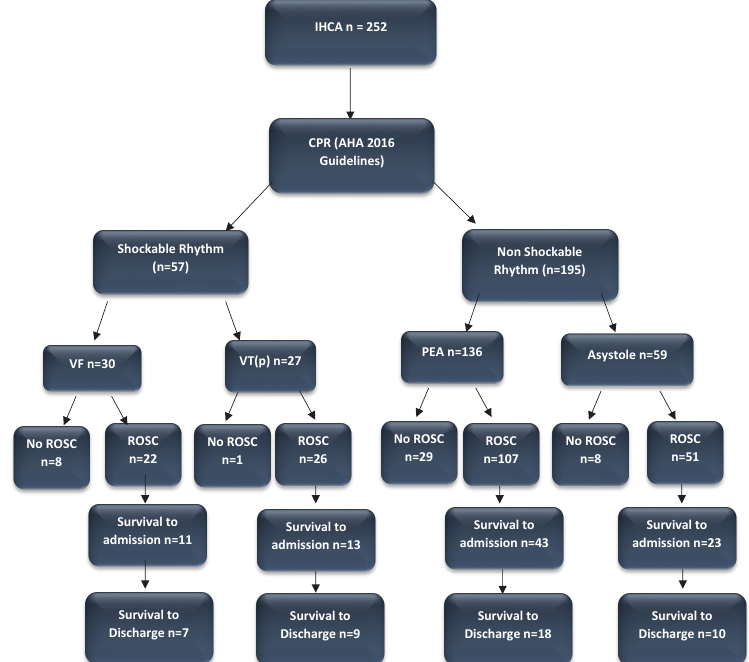
Figure 3. The relationship between initial documented rhythm and survival to discharge